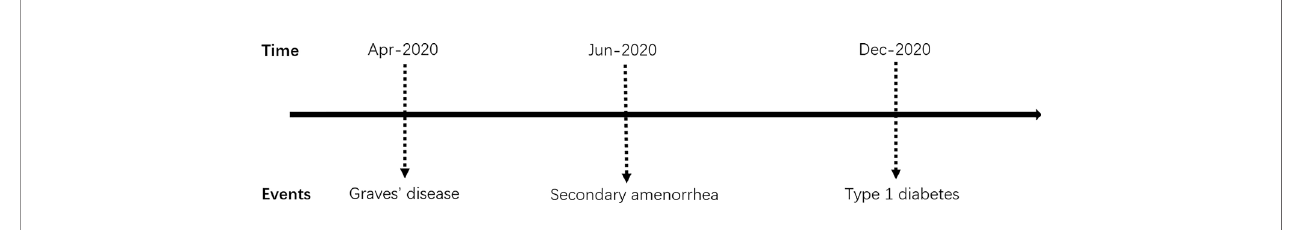
FIGURE 1 | Timeline of the main clinical